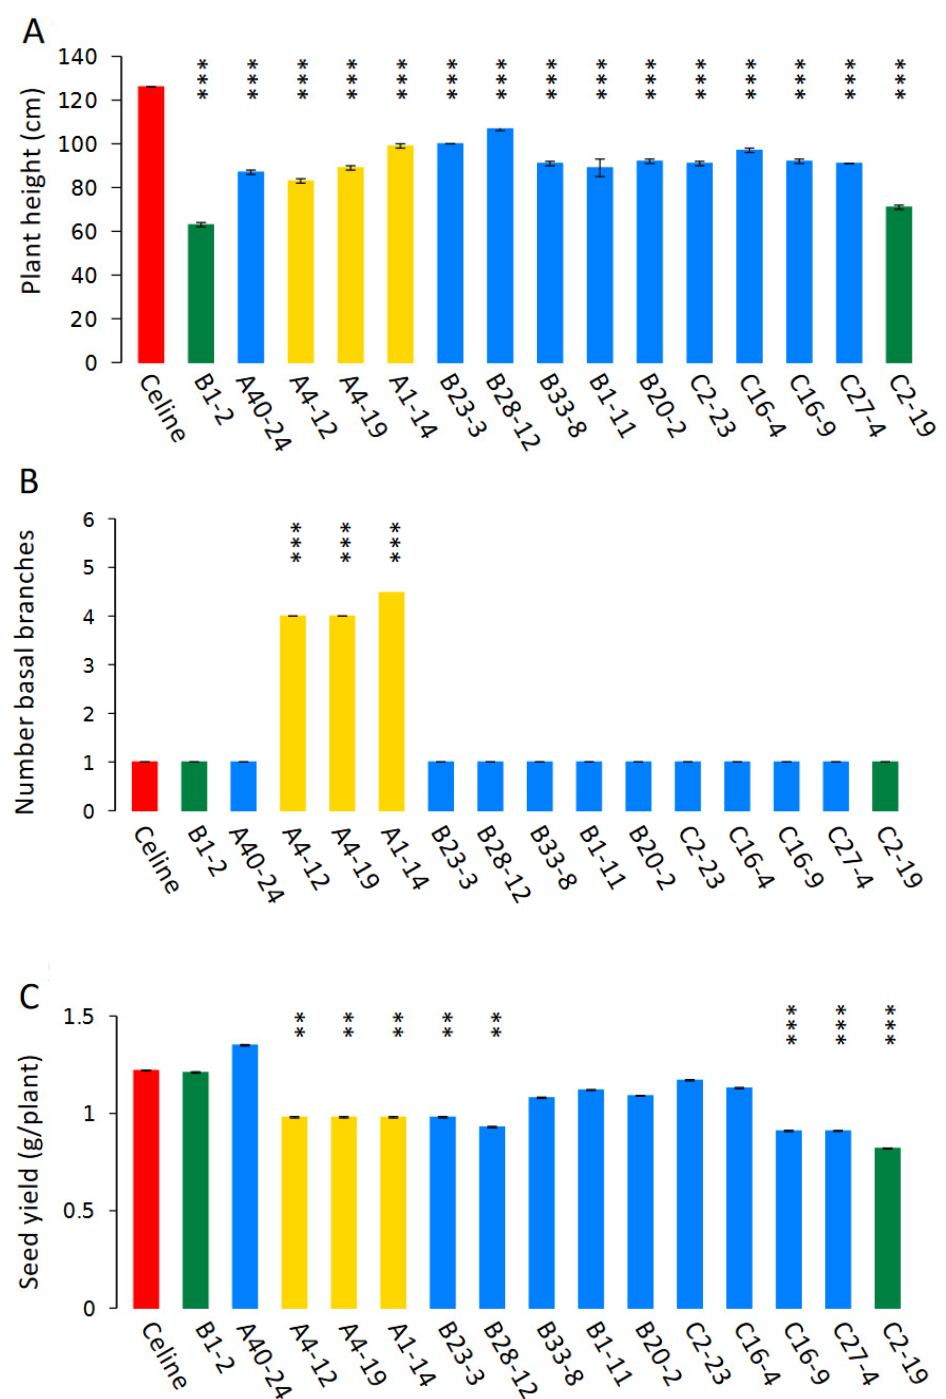
Figure 4. Phenotype of the T5 families. Plants were grown in 24-pot multipots. Final plant height ( A ), number of basal stems/plant ( B ), and seed yield/plant ( C ) were noted for each plant at harvest. The values shown are means +/- SEM. In ( A – C ), n = 24. *** p < 0.001; ** p < 0.01.